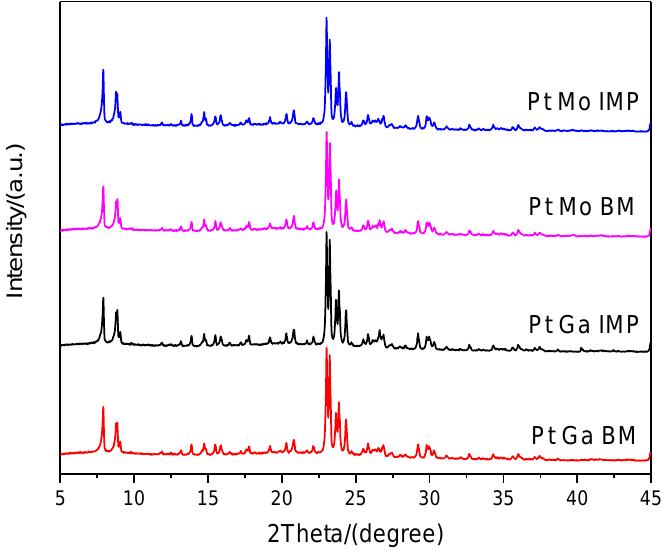
Figure 1. XRD patterns of Pt Mo and Pt Ga samples. All of the samples are reduced at 500 °C for 1 h. IMP—impregnation; BM—ball-milling.